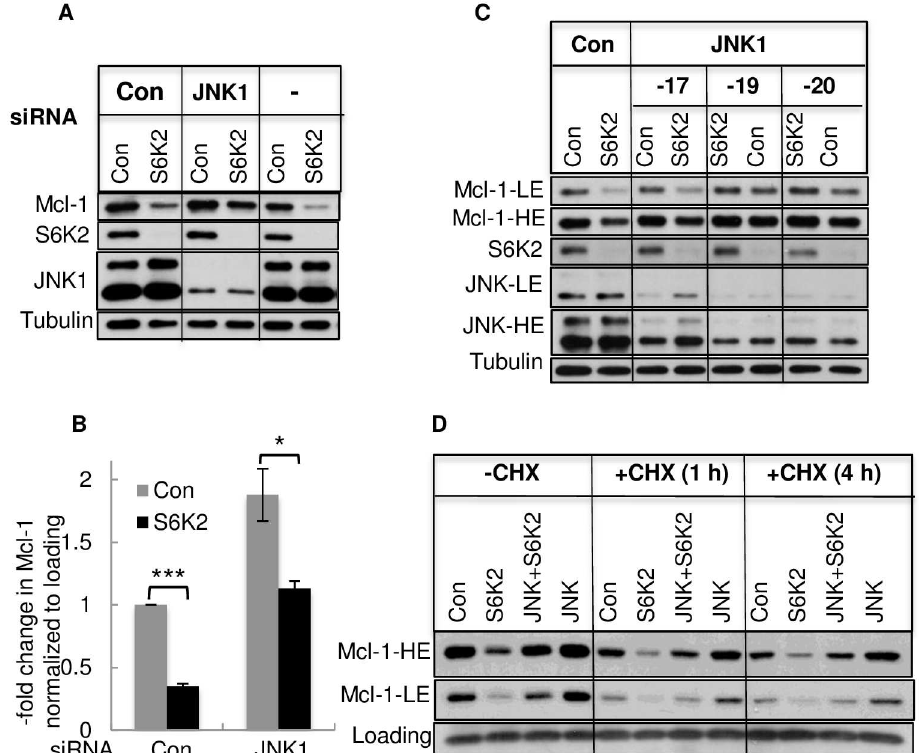
Fig 6. Effects of JNK1 knockdown on S6K2 knockdown-mediated downregulation of Mcl-1. (A). Cells were transfected with or without control or JNK1 siRNA and Western blot analysiswas performed after 72 h. (B). The intensity of Mcl-1 was determined by ImageJ. Each bar represents mean ± S.E. of 6 independent experiments. *** , p < 0.0001; * , p < 0.05using pairedStudent’s t test. (C). Cells were transfected with control non-targeting or individual JNK1 siRNAs for approximately 72 h and Western blot analysiswas performed. (D). Cells treated with indicatedsiRNAs for 48 h were then treated with 10 μ g/ml cycloheximide for 1 h or 4 h, and Western blot analysiswas